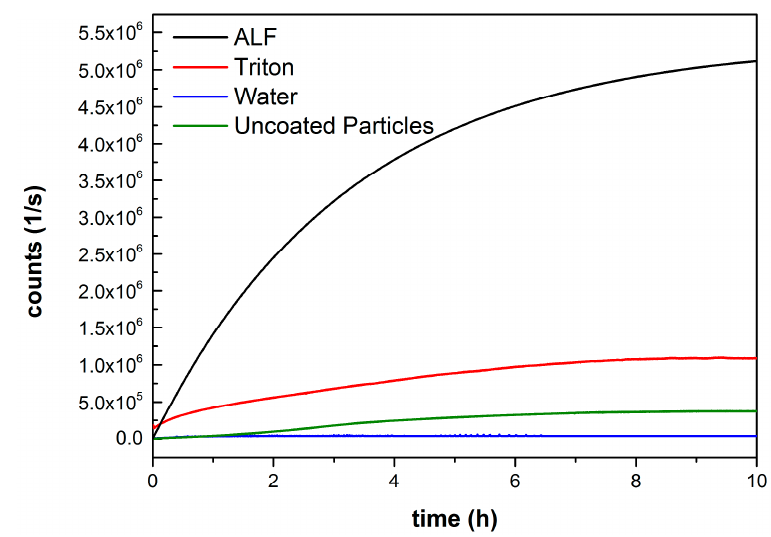
Figure 2. Fluorescence release measurement of Lip-MIL-88A in various solvents. Water ( blue ) and water with addition of Triton X-100 ( red ), as an additional control, as well as ALF ( black ), to simulate the environment of the lysosome. As proof that the liposomes prevent the leakage of the cargo, uncoated particles ( green ) were also measured.